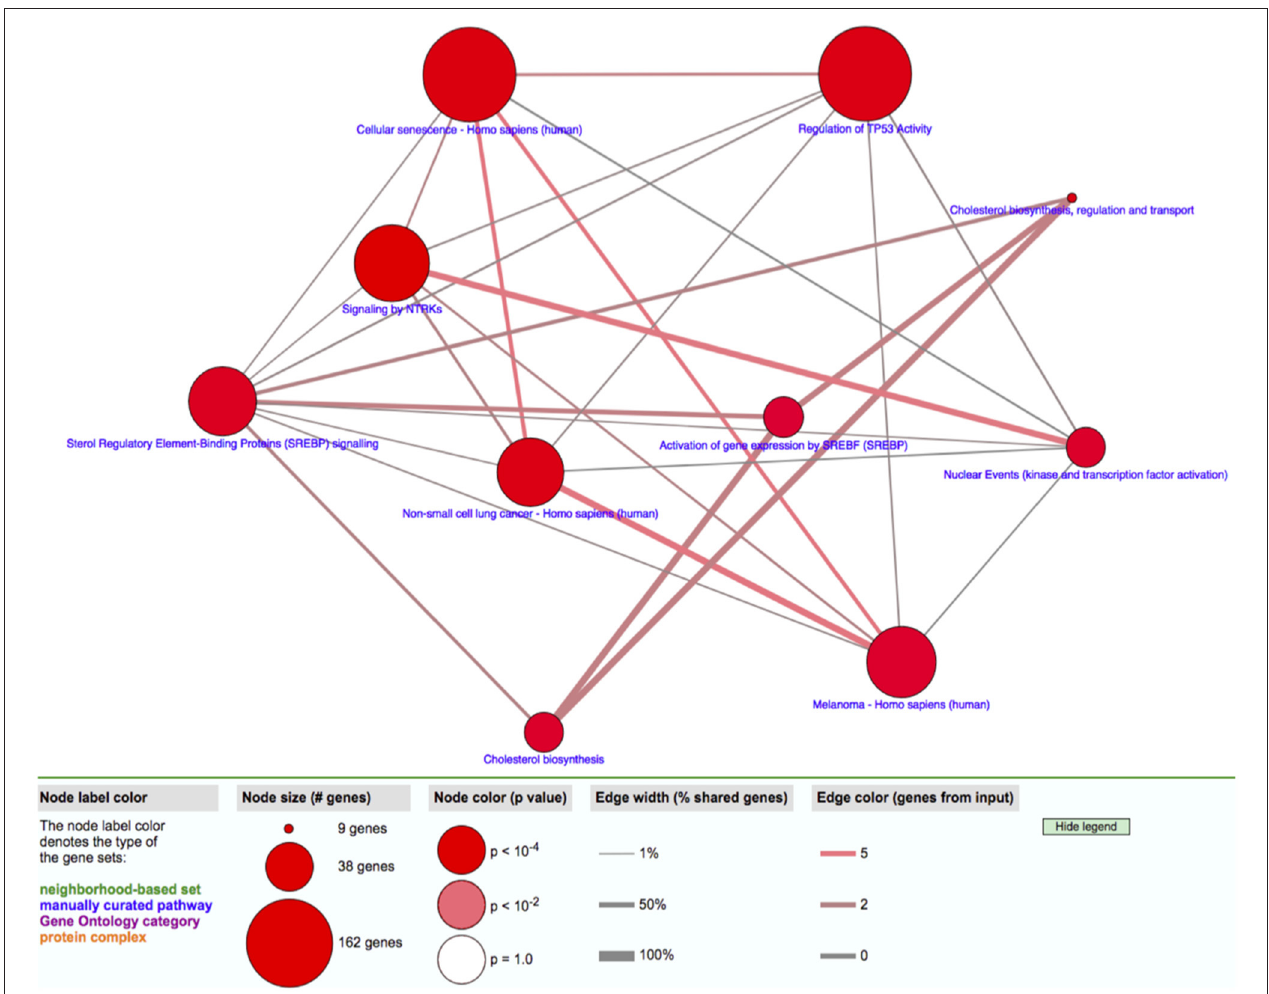
FIGURE 3 | Gene network analysis. The relationship among pathways enriched with candidate genes with expression levels associated with SCQ scores is shown.